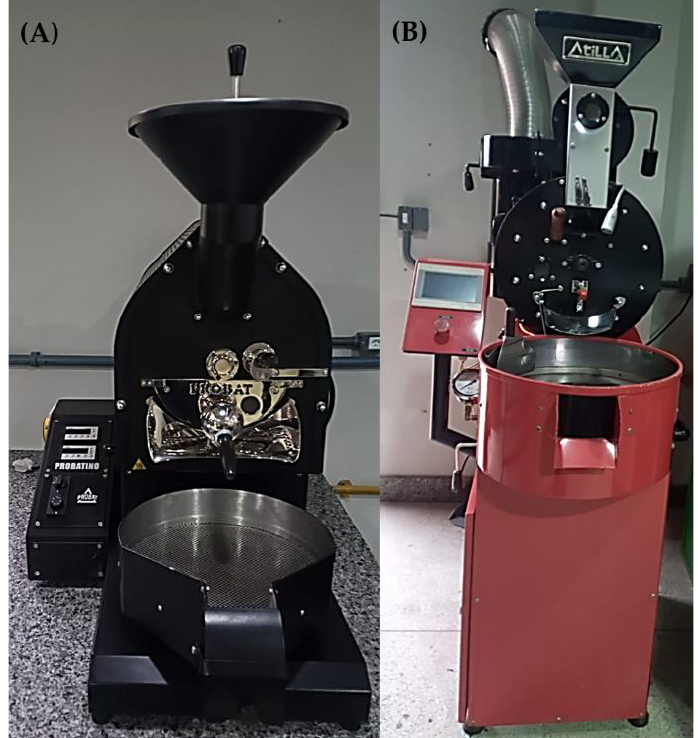
Figure 1. Probatino ( A ) (Probat, Emmerich am Rhein, Germany) and Golden Plus ( B ) (Atilla, Belo Horizonte, Brazil) roasters used in this study.